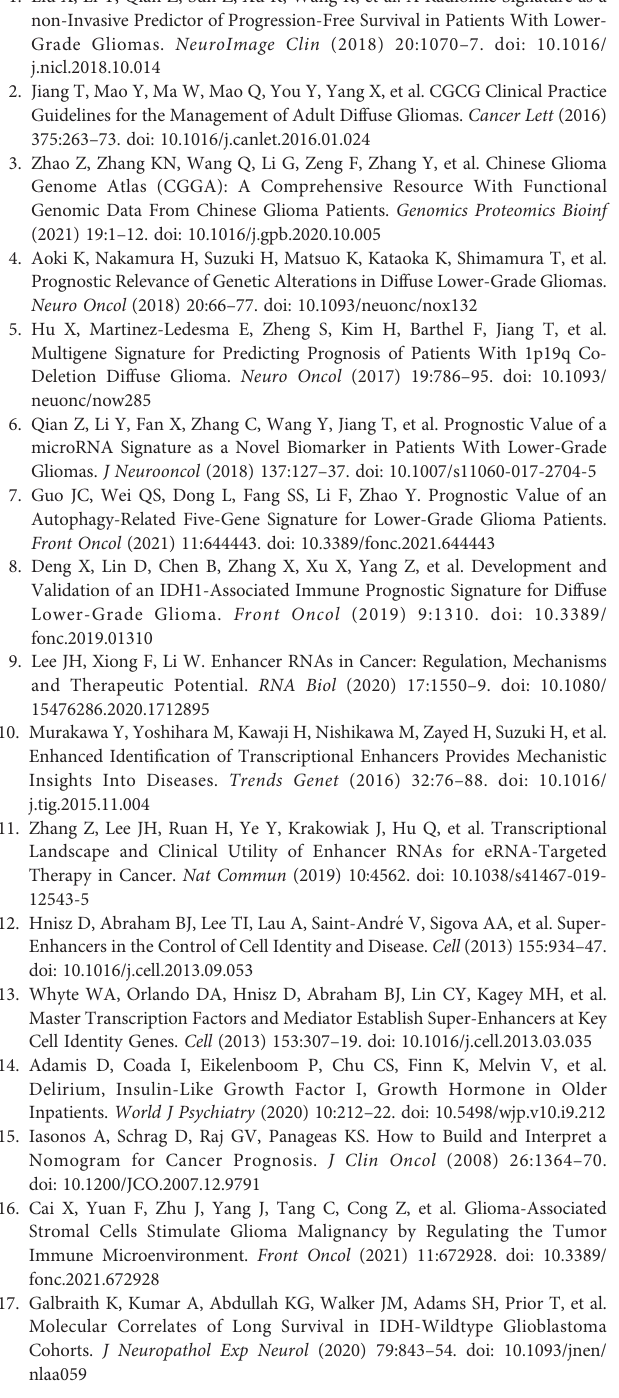
Supplementary Table 5 | The PH test results for the prognostic model. Supplementary Table 6 | The GSEA results in the positive correlative group.